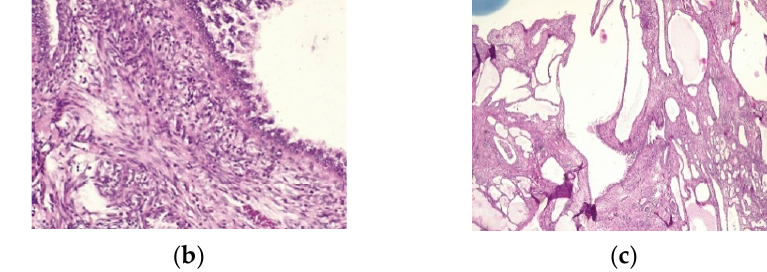
Figure 4. ( a – c )—detail—H&E stain—Trachelectomy specimen—Cervix with previous conization—